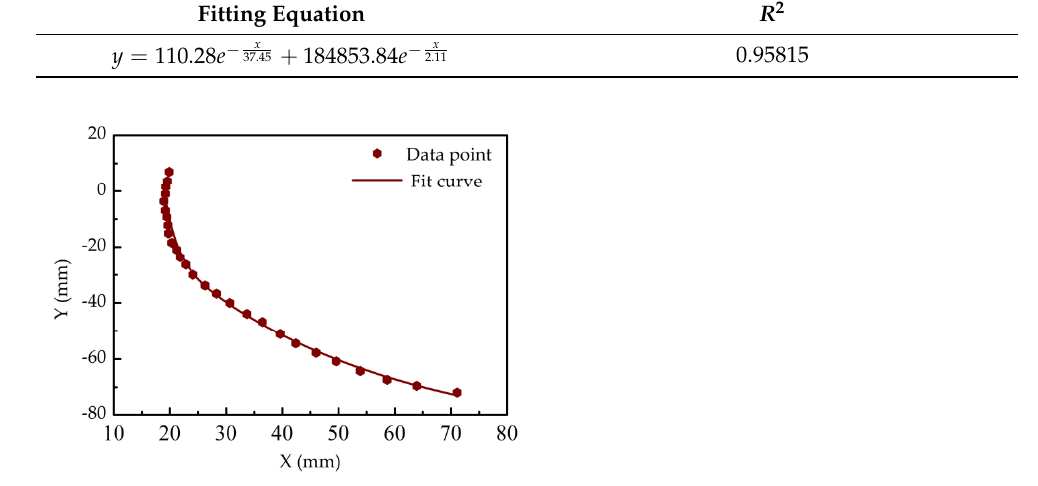
Figure 12. Fitting curve of the bionic surface of the bionic liquid fertilizer deep application spray needle. Table 4. Curve fitting results.